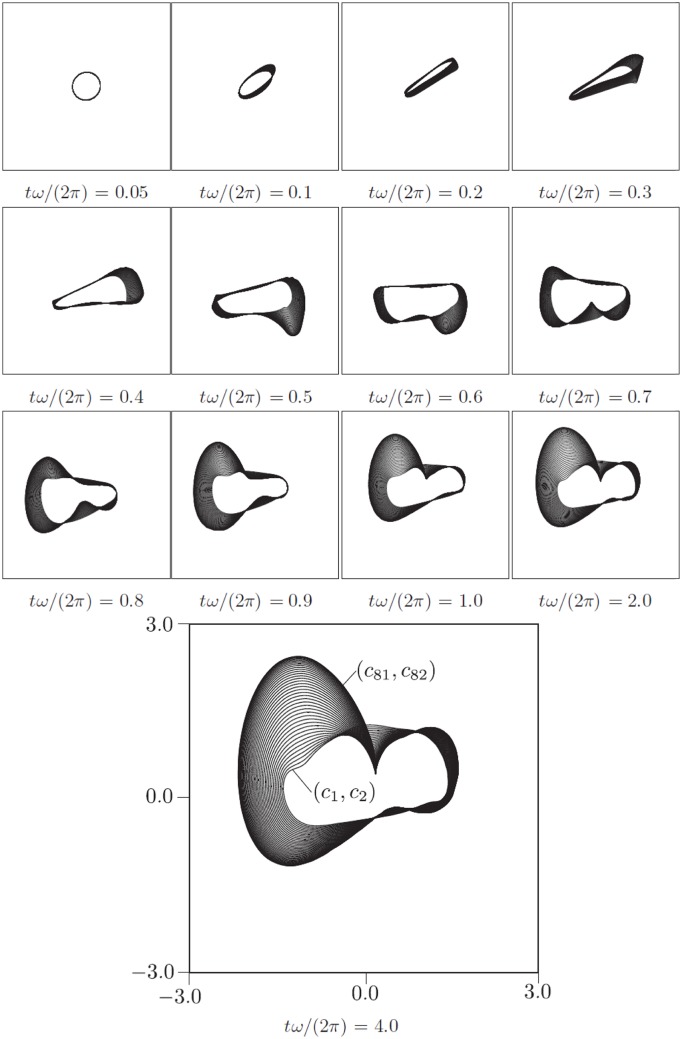
Snapshots of projections of the BM c(t) onto coordinate surfaces (y1, y2), (y3, y4), …, (y81, y82) for various times during a simulation for parameter set III in Table 1.Note that the last two figures are largely similar, indicating that the BM is becoming post-transient.